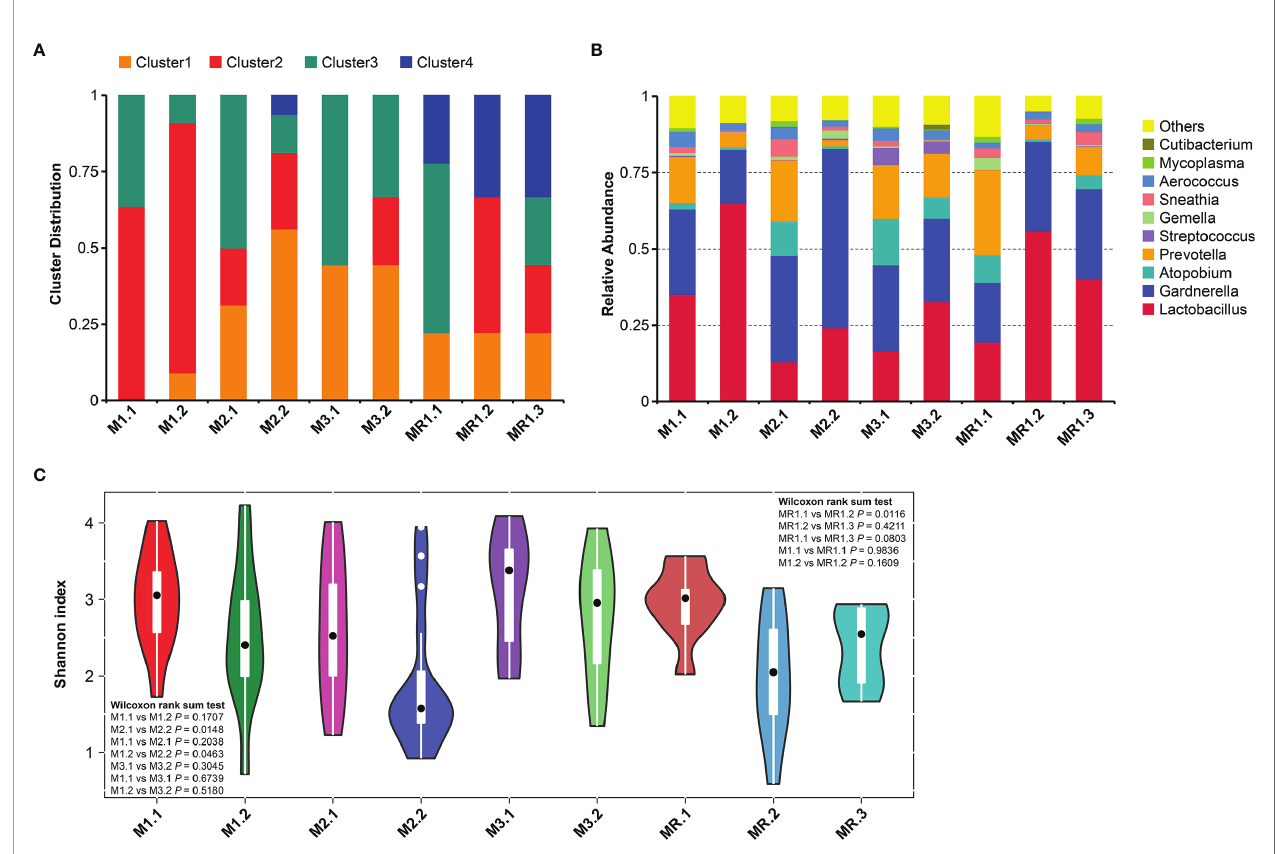
FIGURE 2 | Changes in bacterial vaginal compositions in different patient groups. (A) Microbiota distributions before and after drug treatment. (B) Genus abundances before and after drug treatment. (C) Vaginal microbiome Shannon diversity indexes before and after drug